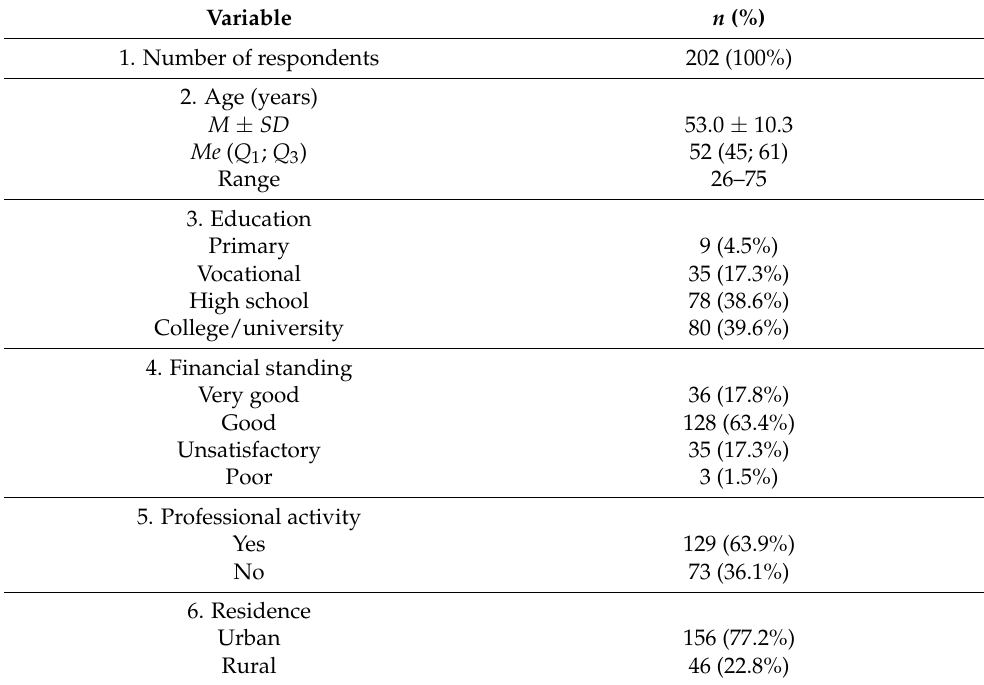
Table 1. General sociodemographic characteristics of the studied patients.